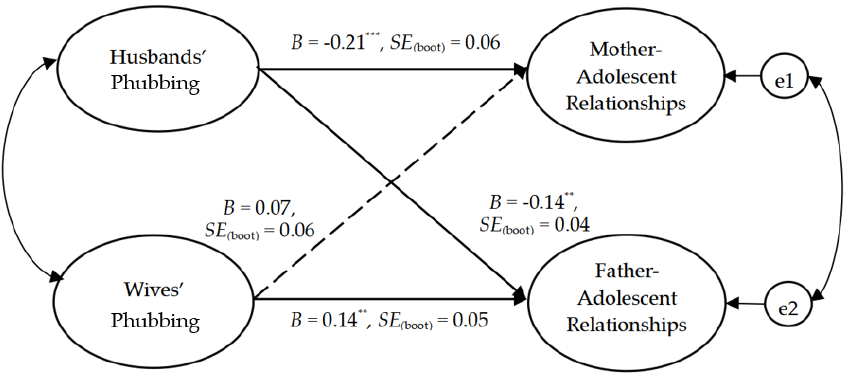
Figure 1. The dyadic model tested in the full sample. Note. N = 441 couples. ** p < 0.01, *** p < 0.001.